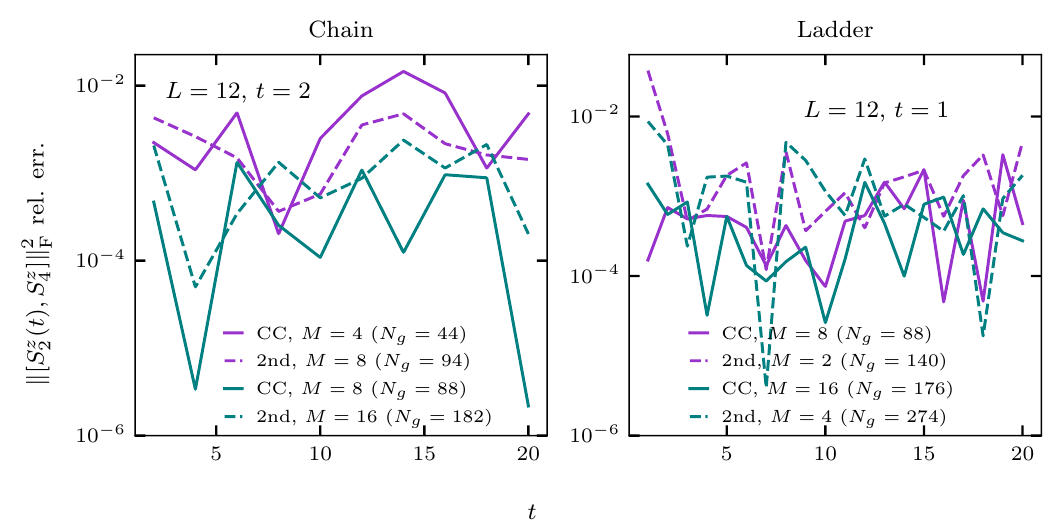
( t ) versus stacking time t for the Figure 15: The relative error of the OTOC C i = 2, j = 4 chain (left panel) and ladder (right panel) with L = 12, for circuits optimized at t = 2 for the chain and t = 1 for the ladder, and stacked up to time t = 20. For the